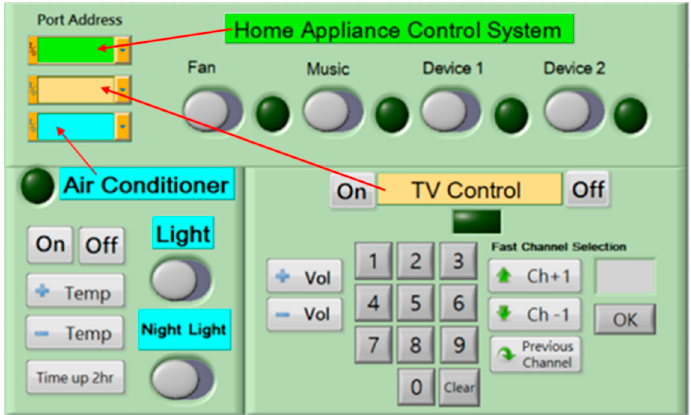
Figure 7. The user interface of the home appliance control system for the severely disabled.